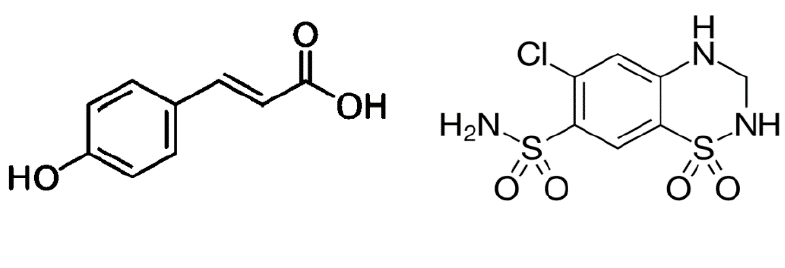
Figure 1. Chemical structure of p -Coumaric acid and hydrochlorothiazide.